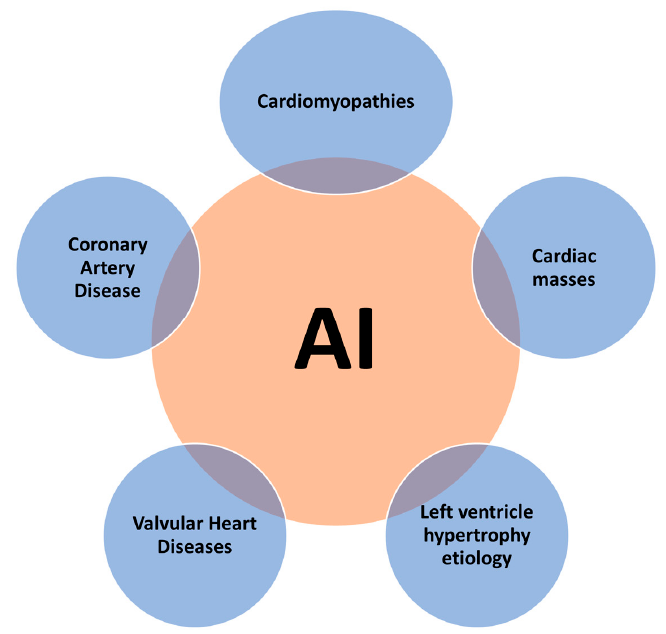
Figure 2. Potential clinical applications of artificial intelligence in echocardiography to identify disease